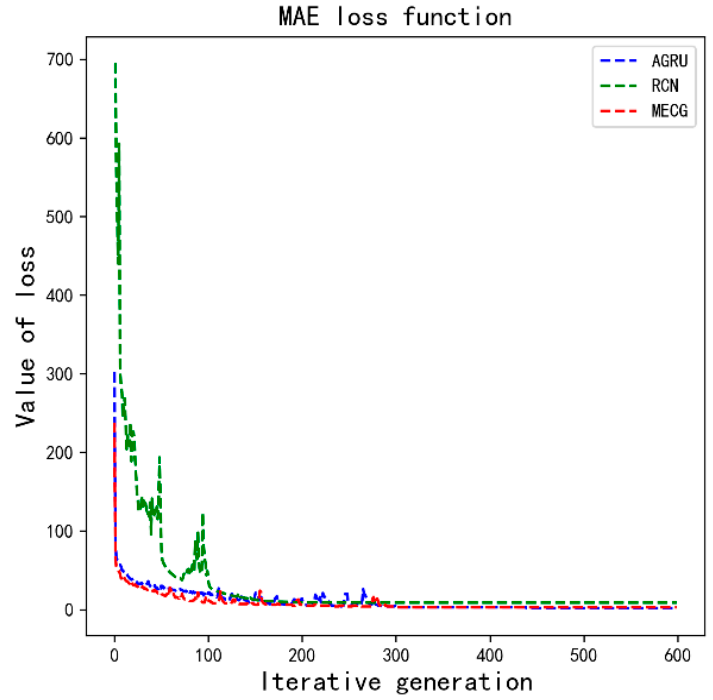
Figure 10. The convergence rate of all models.